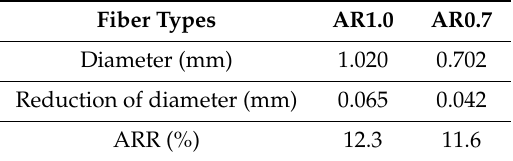
Table 1. Reduction of diameter by cold drawing.